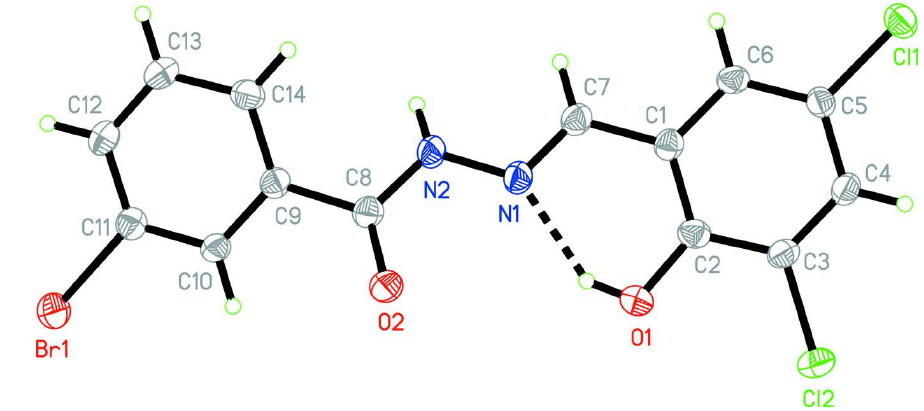
Figure 1 The molecular structure of the title compound, showing 30% probability displacement ellipsoids. The dashed line indicates a hydrogen bond.